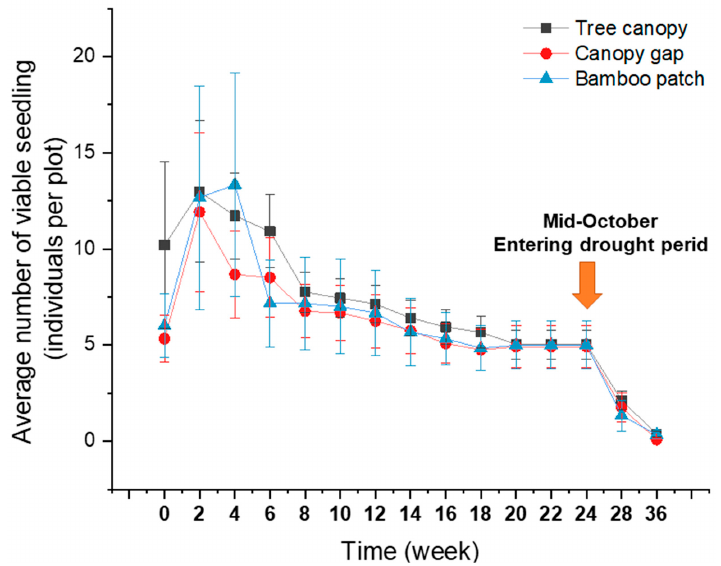
Figure 2. Number of viable seedlings (individuals per plot, mean ± standard error (SE)) in different plot types: the tree canopy, the canopy gap, and the bamboo patch.